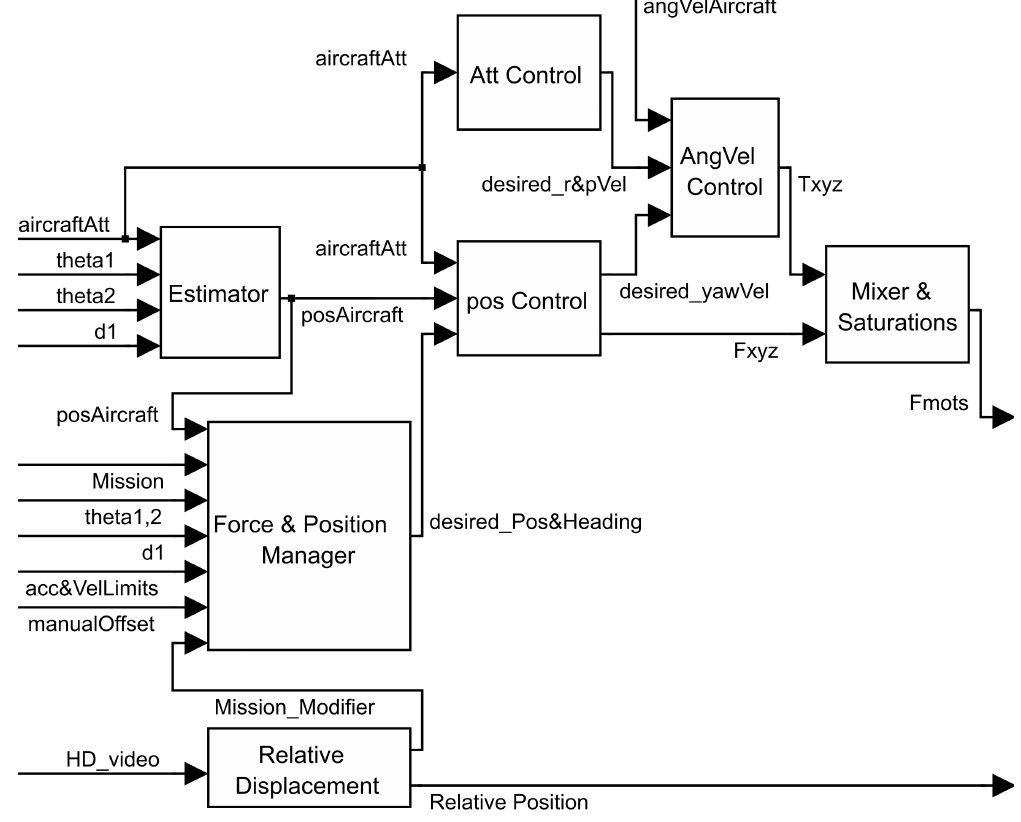
Figure 6. Control architecture of